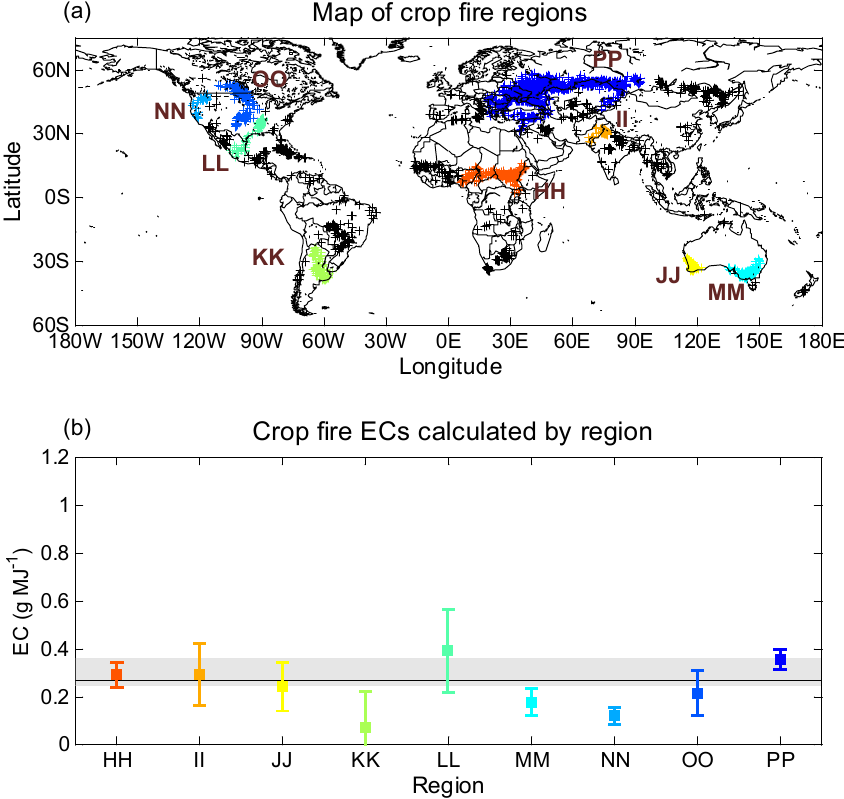
Fig. 6. A map of agricultural fire regions determined by a clustering analysis (a) and ECs calculated individually for each region (b) . In (a) , black markers identify agricultural fires belonging to clusters with less than 100 observations. In (b) , the mean agricultural biome EC is indicated by the black line, while the range of all mean biome ECs (as presented in Table 2) is indicated in grey.